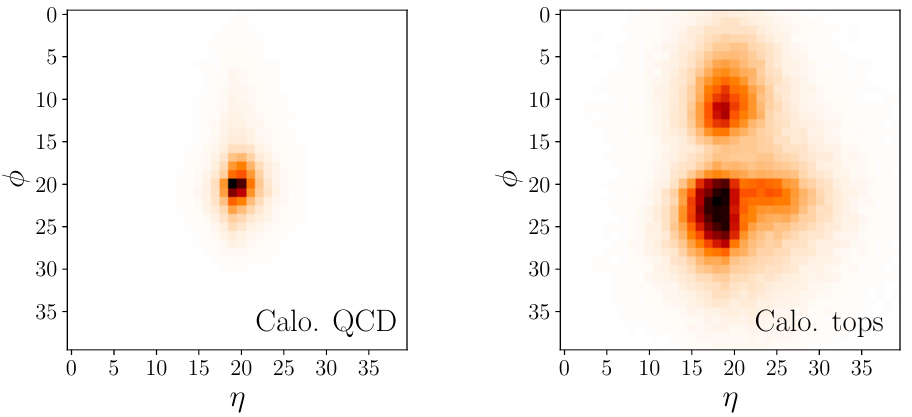
Figure 1: Average of 100k QCD and top jet images after